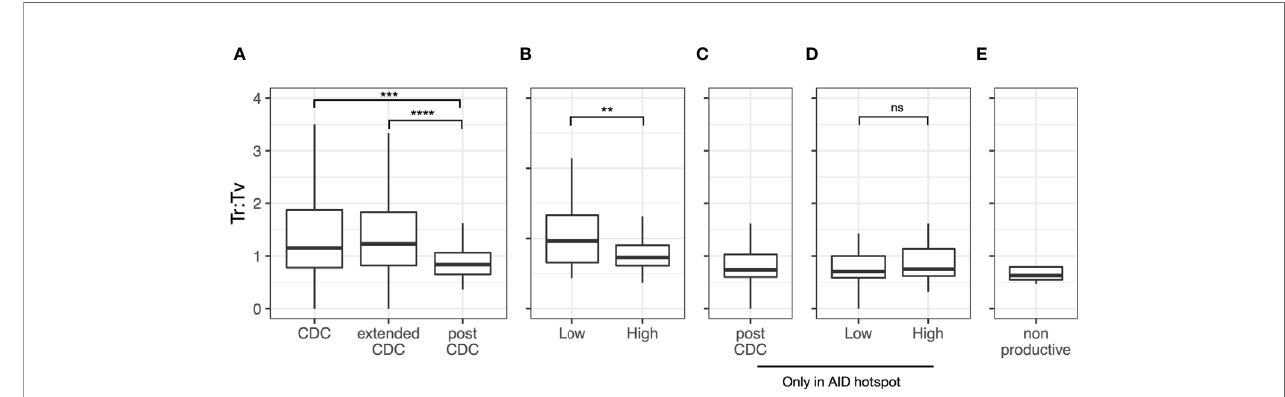
FIGURE 5 | Transition to transversion ratios in the post-CDC mutations. Transition to transversion ratios (Ts : TV) analyzed for: (A) all post-CDC mutations, (B) all post-CDC mutations based on levels of complexity, (C) only those post-CDC mutations involving AID hotspots, (D) post-CDC mutations involving AID hotspots based on levels of complexity and (E) non-productive IGHV-IGHD-IGHJ rearrangements (** P ≤ 0.01, *** P ≤ 0.001, **** P ≤ 0.0001). NS, Not statistically signi